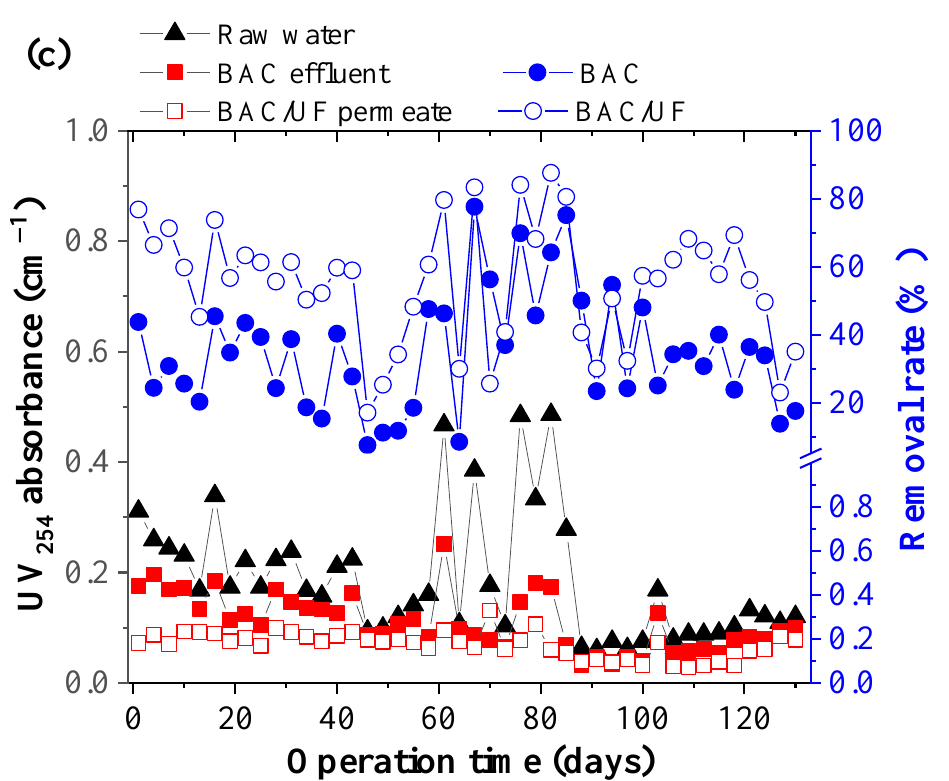
Figure 2. The removal performance of COD Mn and UV 254 by BAC-UF system: ( a ) DO, ( b ) COD Mn , ( c ) UV 254 .